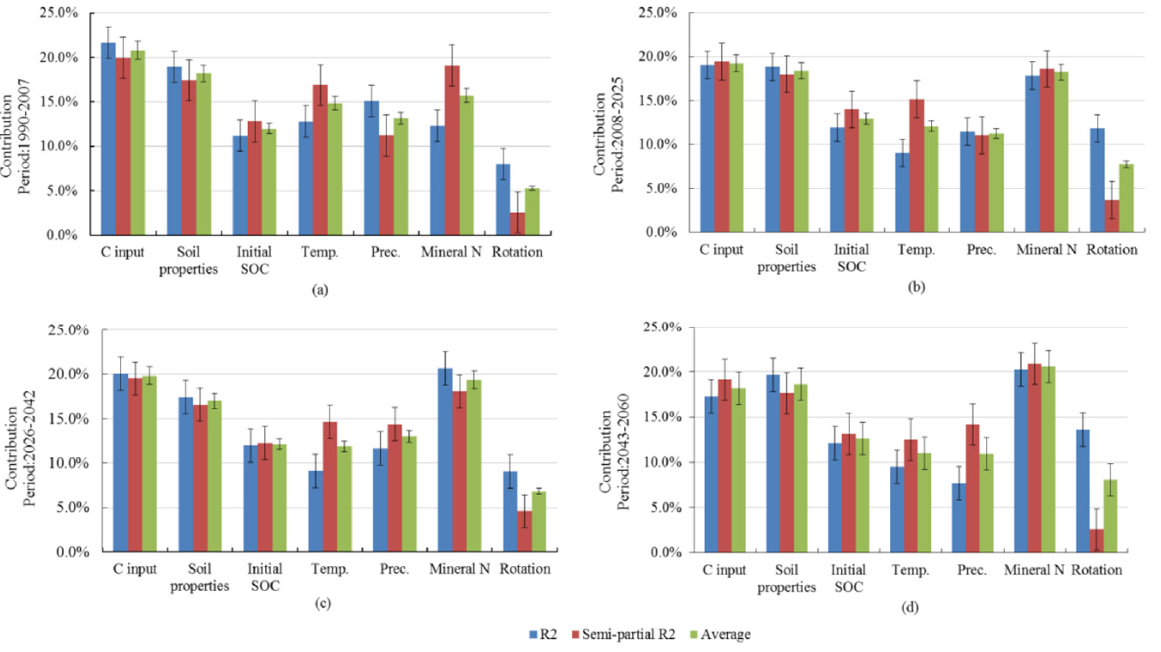
Figure 5. Contribution of factors (C input, soil properties, temperature (Temp.), precipitation (Prec.), mineral N, and rotation) to SOC for the periods 1990–2007 ( a ), 2008–2025 ( b ), 2026–2042 ( c ), and 2042–2060 ( d ), respectively. R 2 and semi-partial R 2 represent the contribution to SOC variance of each variable alone and the contribution of the variable including its interaction with other variables, respectively.